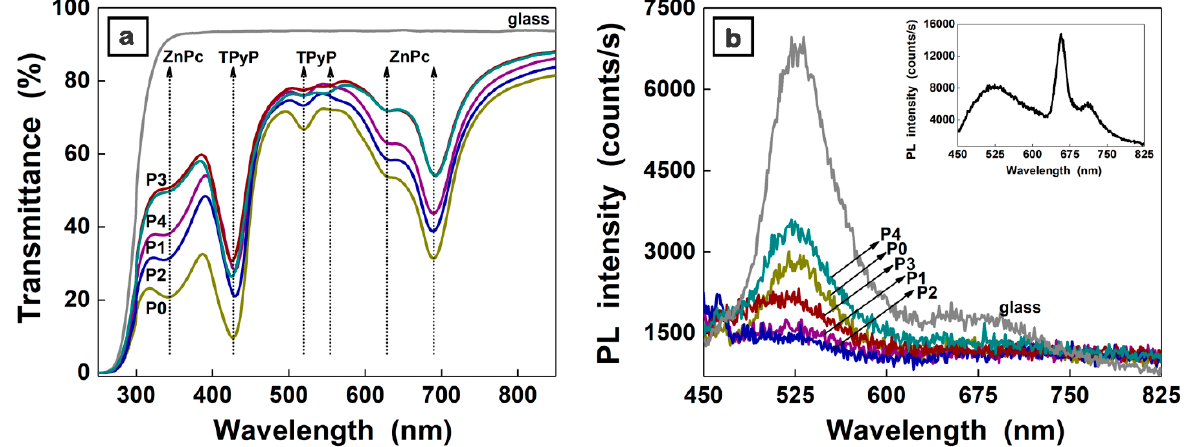
Figure 7. UV–Vis spectra ( a ) and PL spectra ( b ) of the P0–P4 films deposited by MAPLE on glass. Inset: PL spectrum of TPyP film obtained by MAPLE on glass.